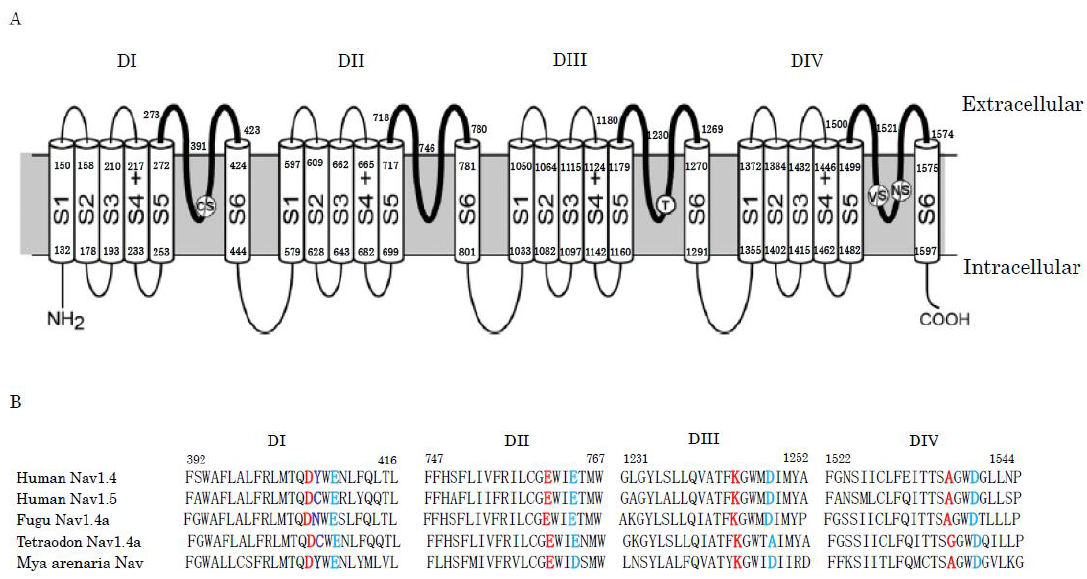
Figure 1. ( A ) Construction of human voltage-gated sodium channel 1.4. ( B ) Comparison of amino acid residues of human Nav1.4, human Nav1.5, Fugu Nav1.4a, Tetraodon Nav1.4a, and Mya arenaria Nav. The amino acid numbering is according to that of human Nav1.4. The GenBank accession numbers are human Nav1.4: P35499; human Nav1.5: Q14524; fugu Nav1.4a: ABB29441; Tetraodon